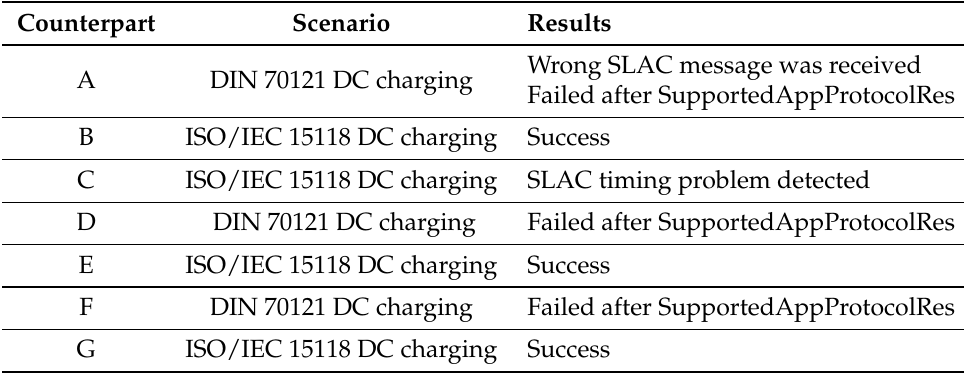
Table 5. Test results at the Tokyo test